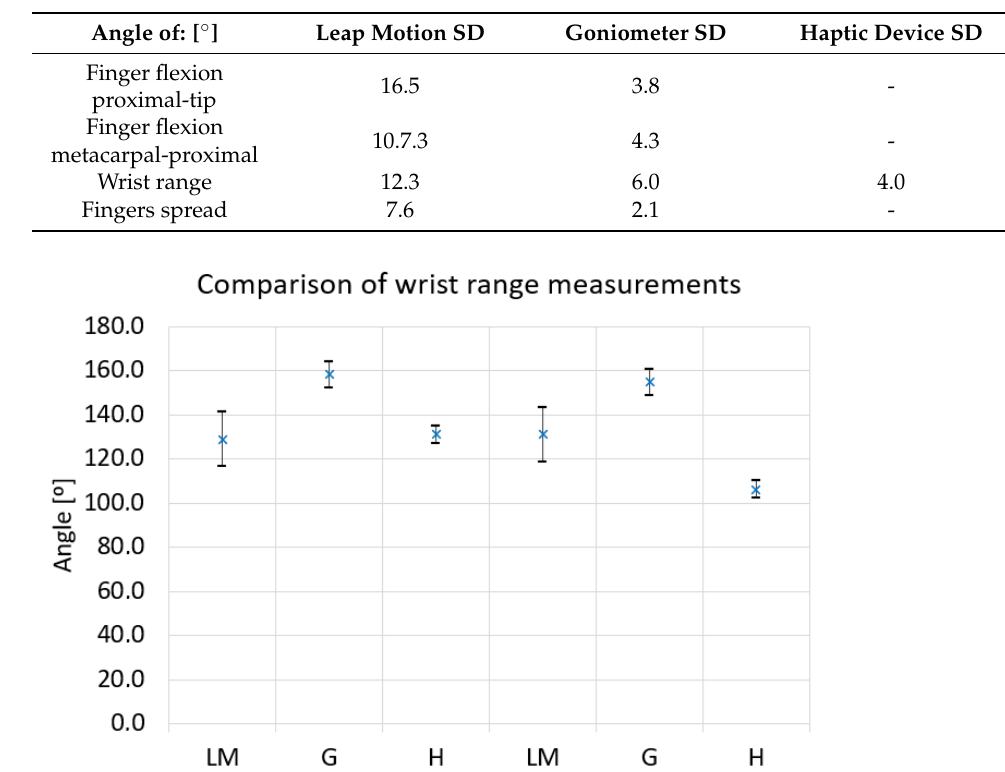
Table 2. Standard deviations (SD) of angle measurements.